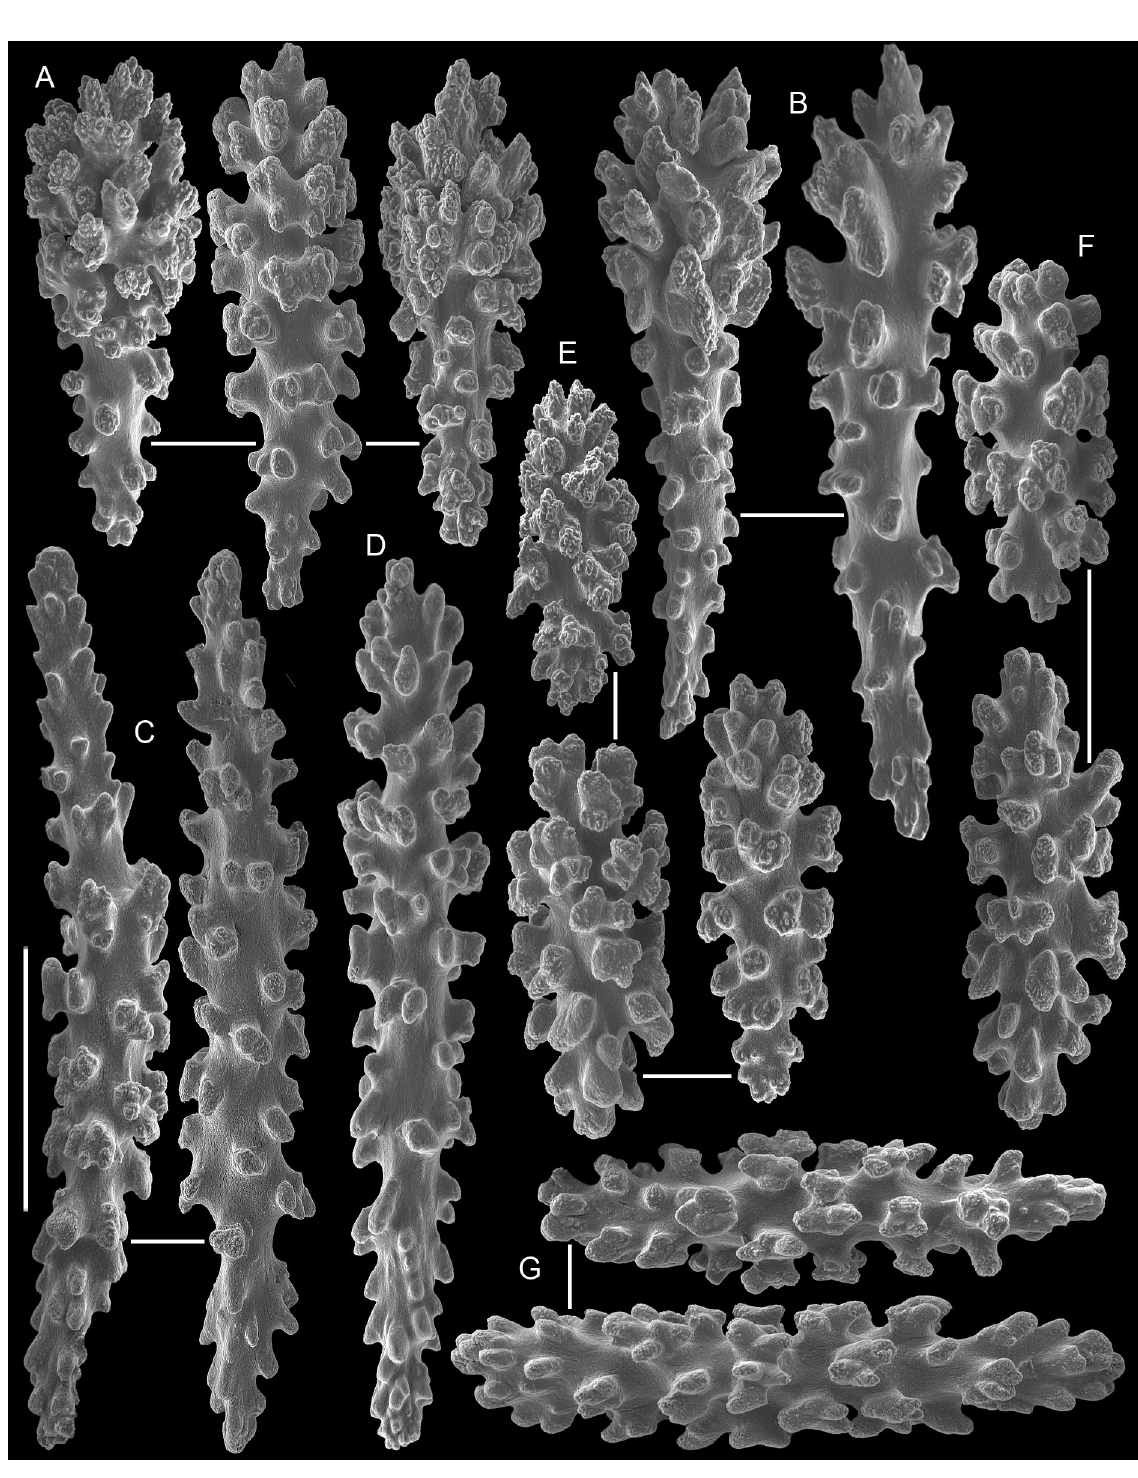
Fig. 12. Calcigorgia simushiri sp. nov., paratype (MIMB 20703), sclerites from the polyp body wall. A . Densely ornamented short clubs. B . Longer clubs with slightly curved handles. C . Tapered spindles ornamented with tubercles. D . Club-like spindle. E . Ovals. F . Capstans ornamented with girdled warts. G . Thick spindles covered by warts tending to be girdled. Scale bar: 0.1